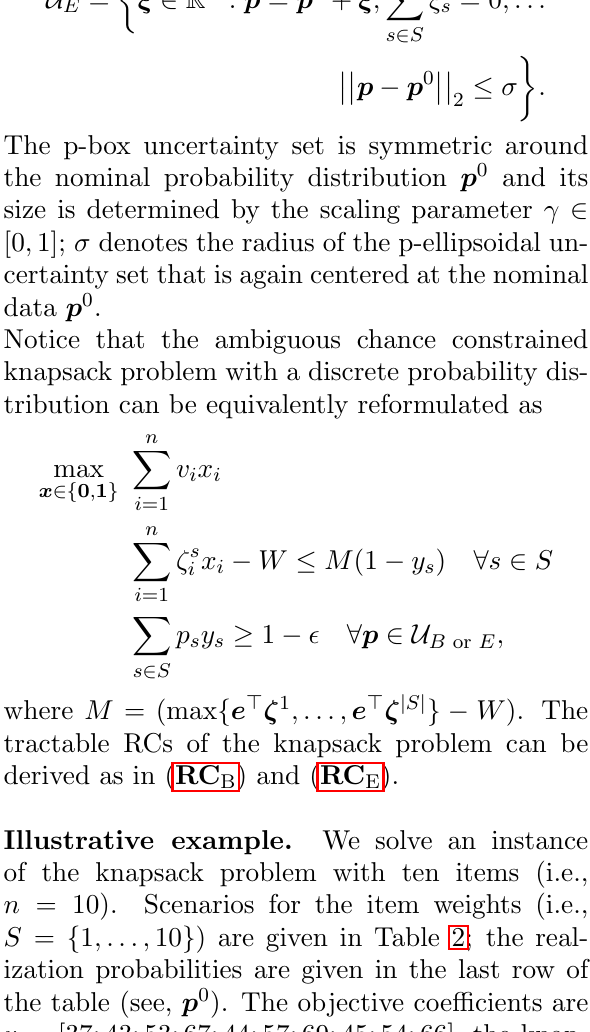
Table 4. Optimal solutions for the ambiguous chance constrained